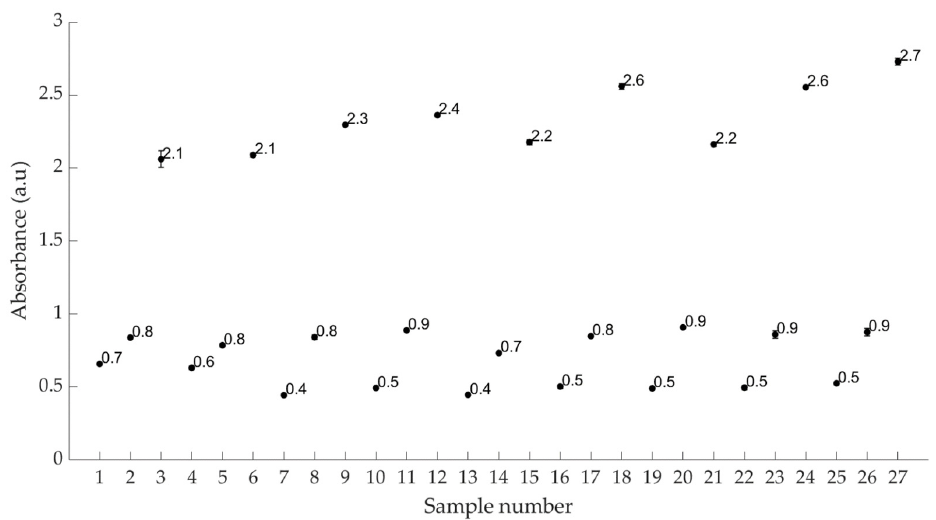
Figure 1. Mean nanoparticle UV–Vis absorbance at ~204 nm per sample group (1–27), giving an indication of nanoparticle count/yield per sample group (95% CI).